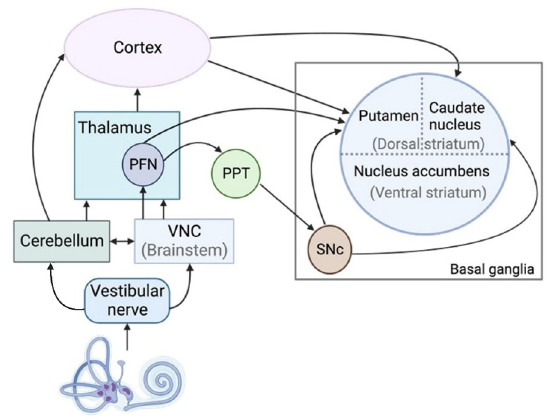
Figure 6. Possible neuronal pathways from the vestibular labyrinth to the striatum via the thalamus, cerebellum and cortex (adapted from Stiles and Smith 33 ). PFN parafascicular nucleus, PPT pedunculopontine tegmental nucleus, SNc substantia nigra pars compacta. Created in